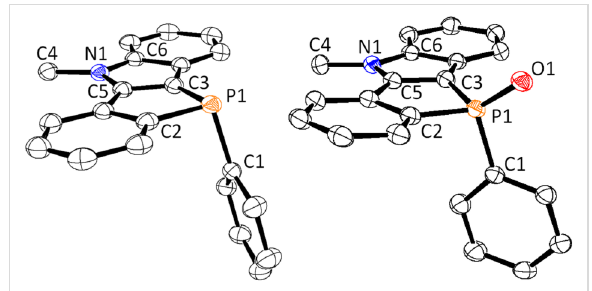
Figure 2: ORTEP drawing of compound 3 (left) and 4 (right) with 50% probability. All hydrogen atoms are omitted for clarity. One of two geometries in the unit cell was drawn for 4 .